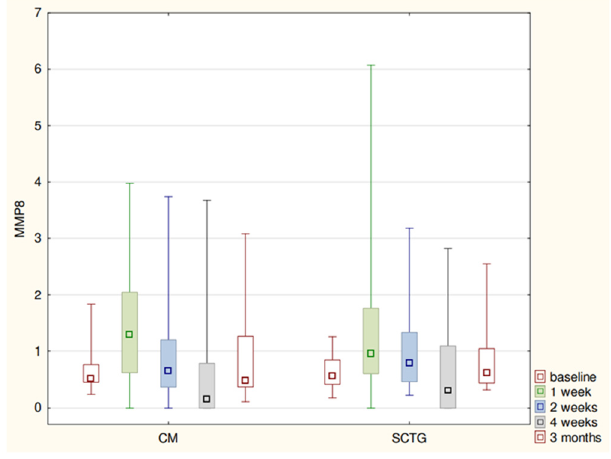
Figure 2. MMP8 levels (median-quartiles-range) at relevant stages of study.